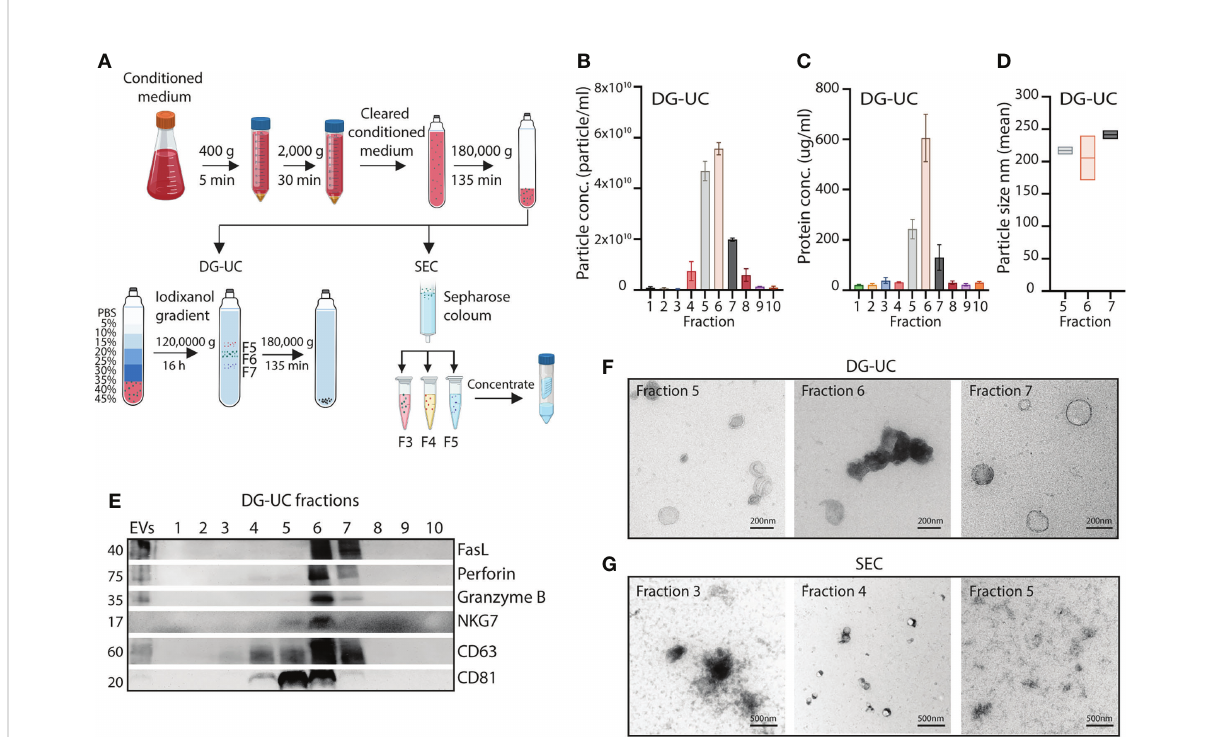
FIGURE 1 Fractionation of subpopulations of NK-EVs via DG-UC or SEC. (A) Work fl ow for isolation of NK-EVs from 48 hrs conditioned medium of IL-15 stimulated NK-92 cells. Cleared conditioned medium was ultracentrifuged, and followed by either DG-UC or SEC as described in Materials and methods. (B) Particle concentration of DG-UC fractions 1-10 measured by NTA. Data are presented as mean ±SEM of 3 independent experiments. (C) Protein concentration of DG-UC fractions 1-10 measured by micro BCA. Data are presented as mean ±SEM of 3 independent experiments. (D) Particle size of DG-UC fractions 5-7 measured by NTA. Data are presented as mean ±SEM of 3 independent experiments. (E) Western blot analysis using 20 µg of EV isolates and bulk EVs of NK-92 cells. Representative of three independent experiments. (F) TEM of DG-UC subpopulation 5-7 (scale bar 200 nm) and (G) TEM of SEC subpopulation 3-5 (scale bar 500